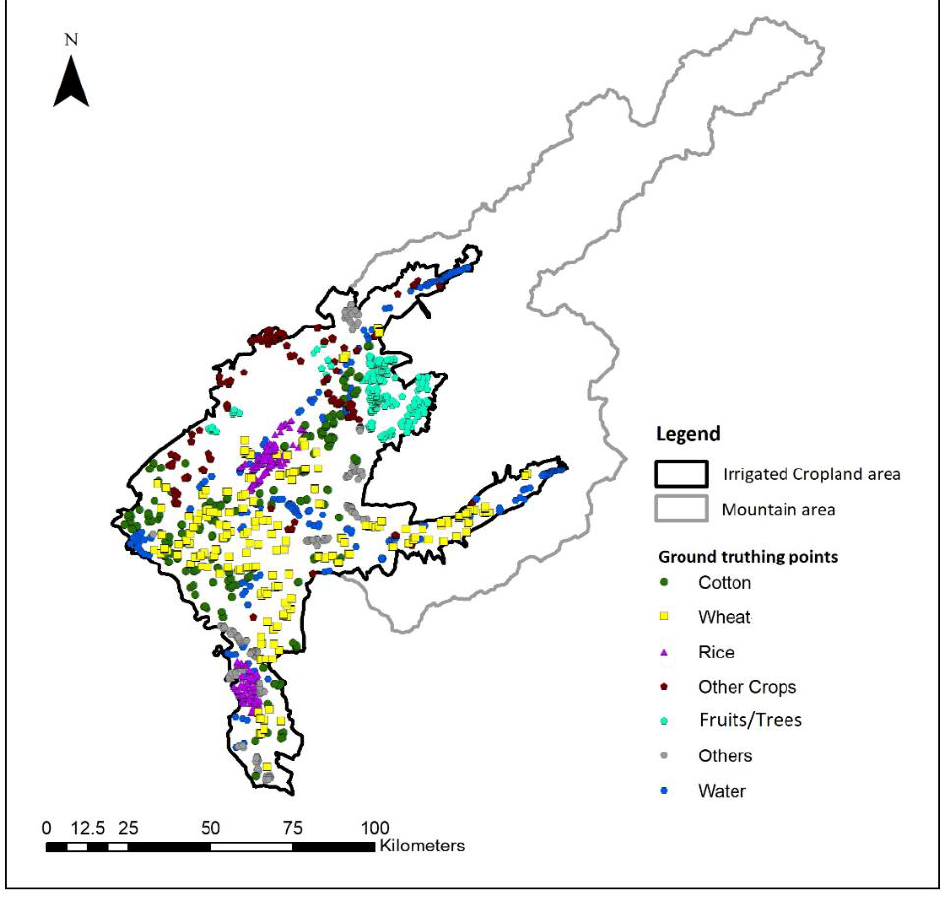
Table 3. Numerical information on training and validation data.